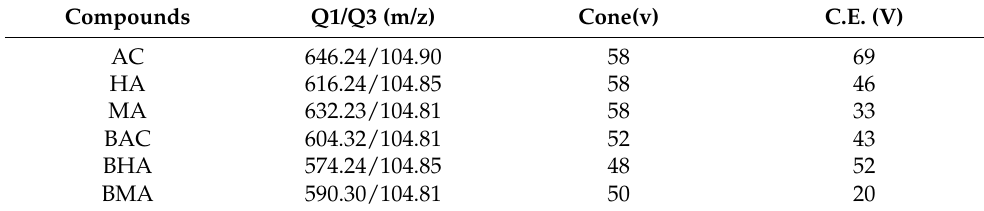
Table 6. Mass Spectra Properties of the